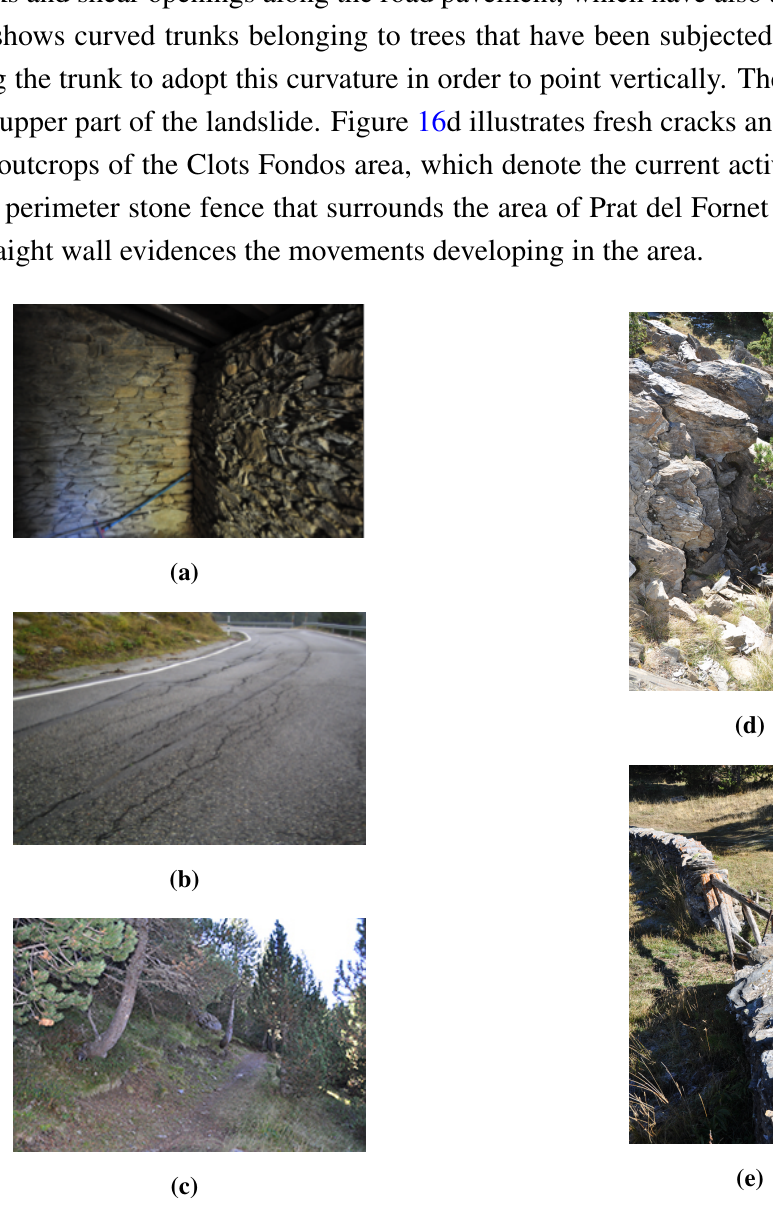
Figure 16. Photographs obtained during the field inspections works carried out during 2013 – 2014 evidencing the activity of El Forn de Canillo. ( a ) Interior view of the cracked walls of a small farmhouse and ( b ) cracks along road pavement located close to the area of Cal Borró–Cal Ponet; ( c ) curved trunks belonging to trees that have been subjected to a progressive tilt; ( d ) fresh cracks and openings within the rock mass in the outcrops of the Clots Fondos area; ( e ) perimeter stone fence that surrounds the area of Prat del Fornet